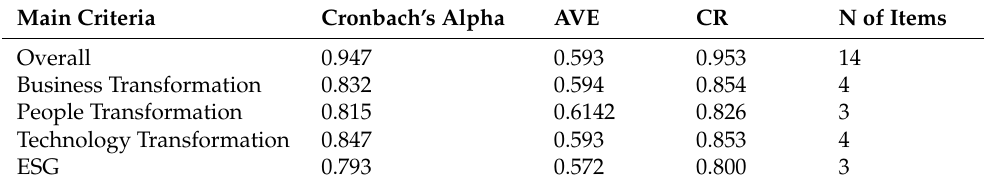
Table 7. Reliability Statistics of each